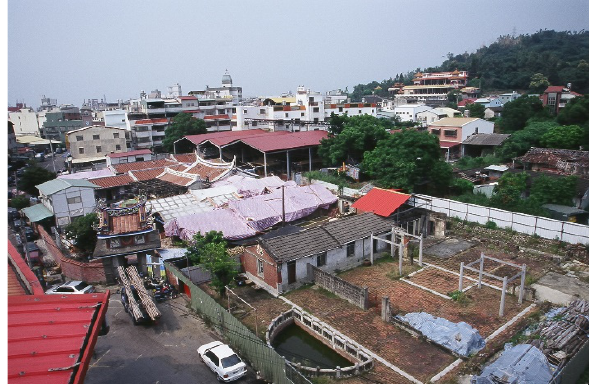
Figure 7: Sept. 21, 1999, most of the historical buildings of Lin Family in Taichung had toppled during the great